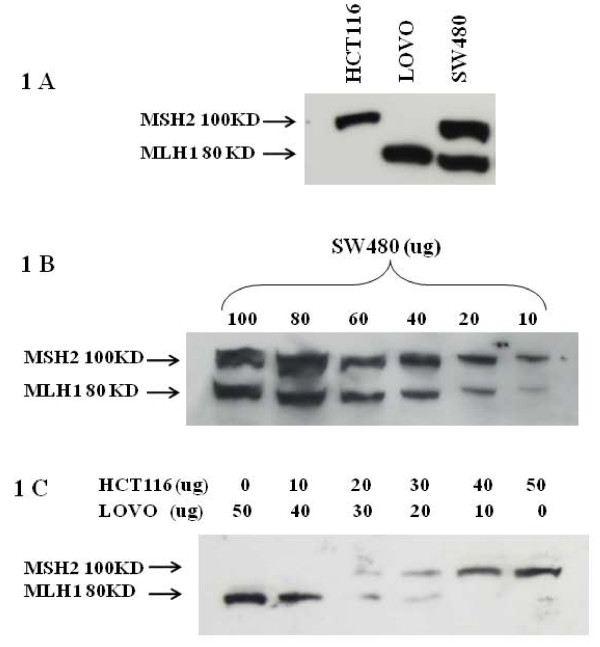
Detection of MLH1 and MSH2 proteins using combined MLH1 and MSH2 monoclonal antibodies on the same blot. (A) HCT116 and LoVo cells were used as controls for the absence and presence of MLH1 and MSH2 proteins, respectively, whereas SW480 cells were used for the presence of both these proteins. There was no apparent cross-reactivity. (B) Different concentrations of SW480 cell extracts were used for western blotting to establish simultaneous detection of both proteins. Results indicated that the combined antibodies were able to specifically detect their respective antigens in a dose dependent manner. MLH1 and MSH2 proteins could be detected in samples containing as little as 10 ug of total cell protein. (C) Detection of MLH1 and MSH2 proteins on western blots with a mixture of varying amounts of HCT116 and LoVo cell lysates. Results show that the combinations of these two monoclonal antibodies were able to detect MLH1 and MSH2 proteins even when these proteins were present in a sample in different proportions.